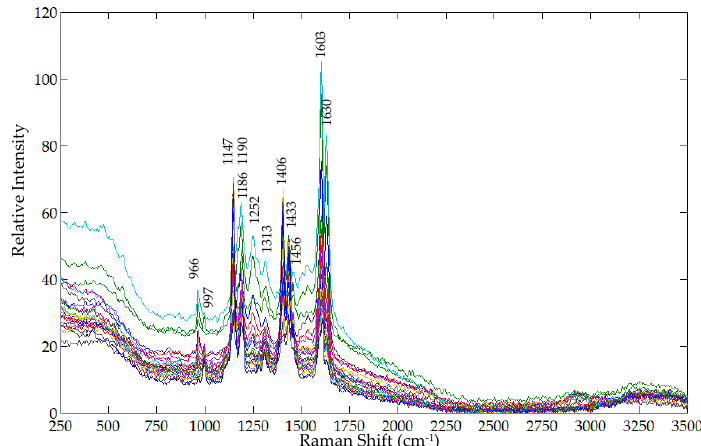
Figure 4. Original FT-Raman spectra of mixture samples at all concentration levels.